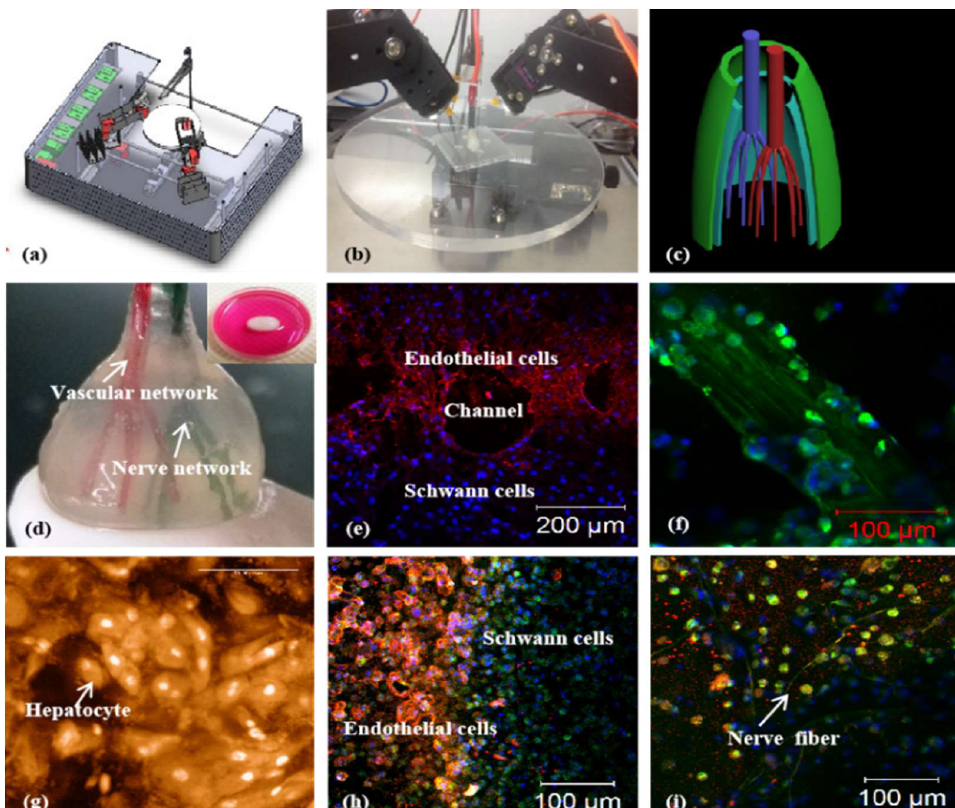
Figure 8. A combined four-nozzle 3D organ bioprinting technology created in Prof. Wang’s laboratory at Tsinghua University in 2013. Adapted from Ref. [49]: ( a ) equipment of the combined four-nozzle 3D organ bioprinter; ( b ) working state of the combined four-nozzle 3D organ printer; ( c ) a CAD model representing a large-scale vascularized and innervated hepatic tissue; ( d ) a semielliptical 3D construct containing a poly (lactic-co-glycolic acid) (PLGA) overcoat, a hepatic tissue made from hepatocytes in a gelatin/chitosan hydrogel, a branched vascular network with fully confluent endothelialized ASCs on the inner surface of the gelatin/alginate/fibrin hydrogel, and a hierarchical neural network made from Schwann cells in the gelatin/hyaluronate hydrogel; the maximal diameter of the semiellipse can be adjusted from 1 mm to 2 cm according to the CAD model; ( e ) a cross section of ( d ), showing the endothelialized ASCs and Schwann cells around a branched channel; ( f ) a large bundle of nerve fibers formed in ( d ); ( g ) hepatocytes underneath the PLGA overcoat; ( h ) an interface between the endothelialized ASCs and Schwann cells in ( d ); ( i ) some thin nerve fibers.